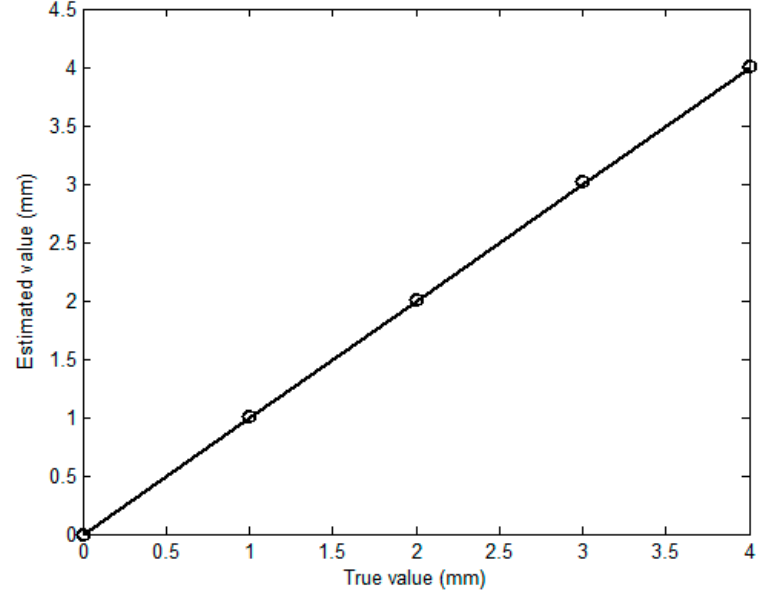
Figure 9. Comparison between the approximated corrosion depths and true values.